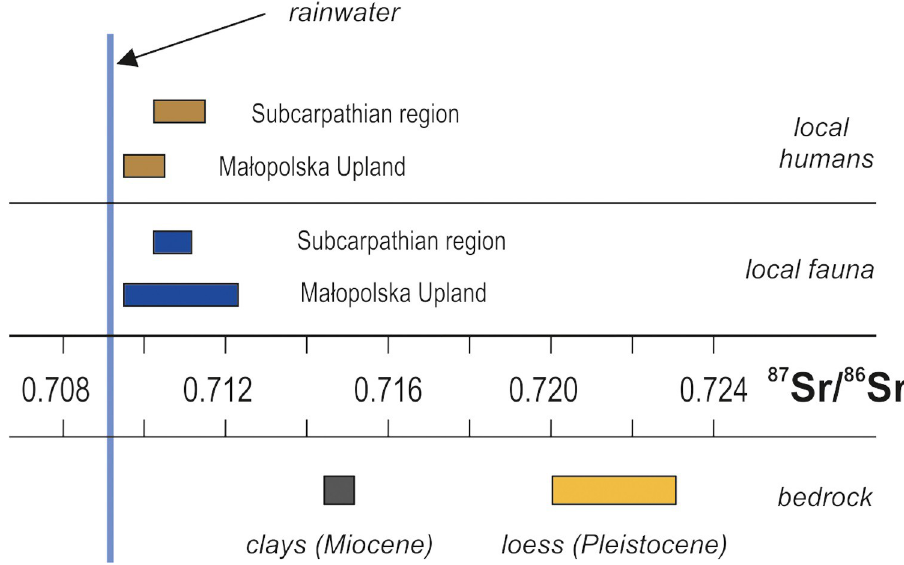
Fig 8. Ranges of 87 Sr/ 86 Sr ratios in Final Neolithic human and animal enamel from the Małopolska Upland and the Subcarpathian region, along with values for local geological bedrock and rainwater in the studied